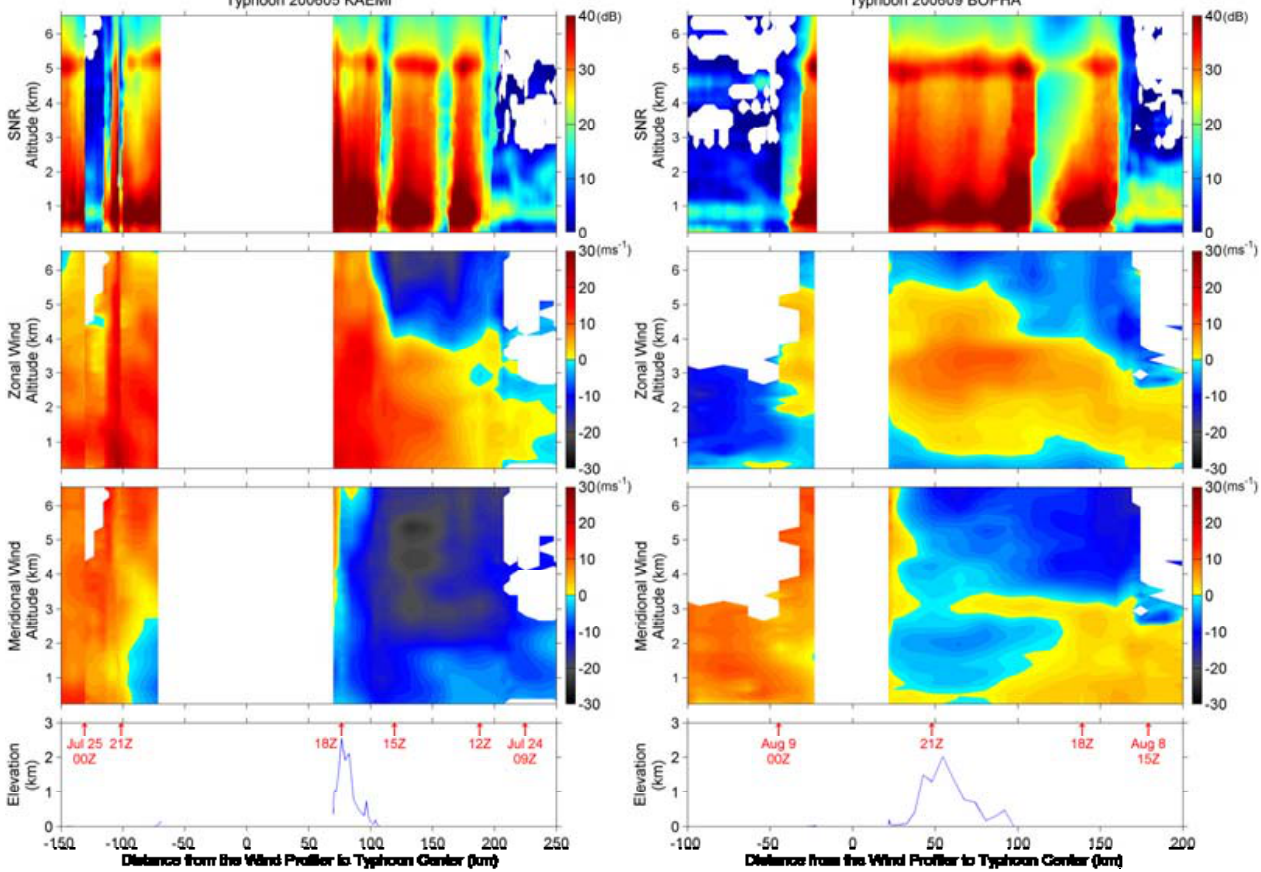
Fig. 4. The height-time distributions of the signal-to-noise ratio (the top panel) and the zonal and meridional components of the winds (the second and the third panels). The bottom panel shows the distances between the wind profiler and the Typhoon center with respect to the progress of time and orography of the CMR. The left and the right panel represent the typhoon Kaemi and Bopha, respectively.